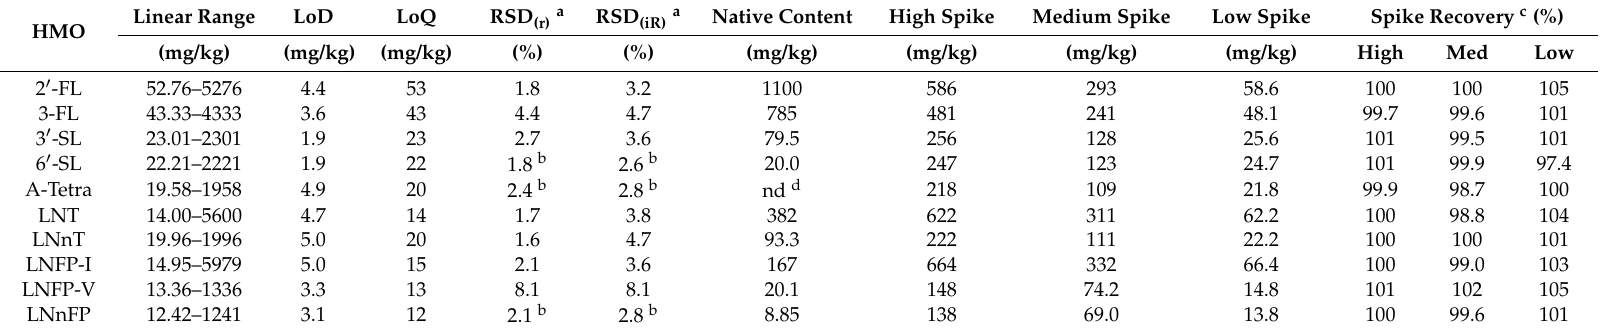
Table 2. Analytical method performance.